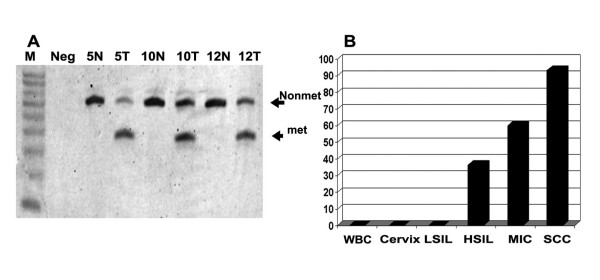
Schematic representation of methylation-specific PCR in CC. (A) PCR analysis of CC: M, DNA size marker; Neg, water; N and T, matched normal cervices and tumors, respectively. (B) Bar graph demonstrating the frequency of DNA methylation. Numbers on the y-axis are the percentage of positive methylation cases. Sample types are on the x-axis. WBC, normal cervix, Low-grade SIL, High-grade SIL, microinvasive cancer and squamous cell CCs number are 43, 25, 13, 11, 5, and 30, respectively. The methylation frequencies of each tissue type are represented by the height of each rectangular bar.